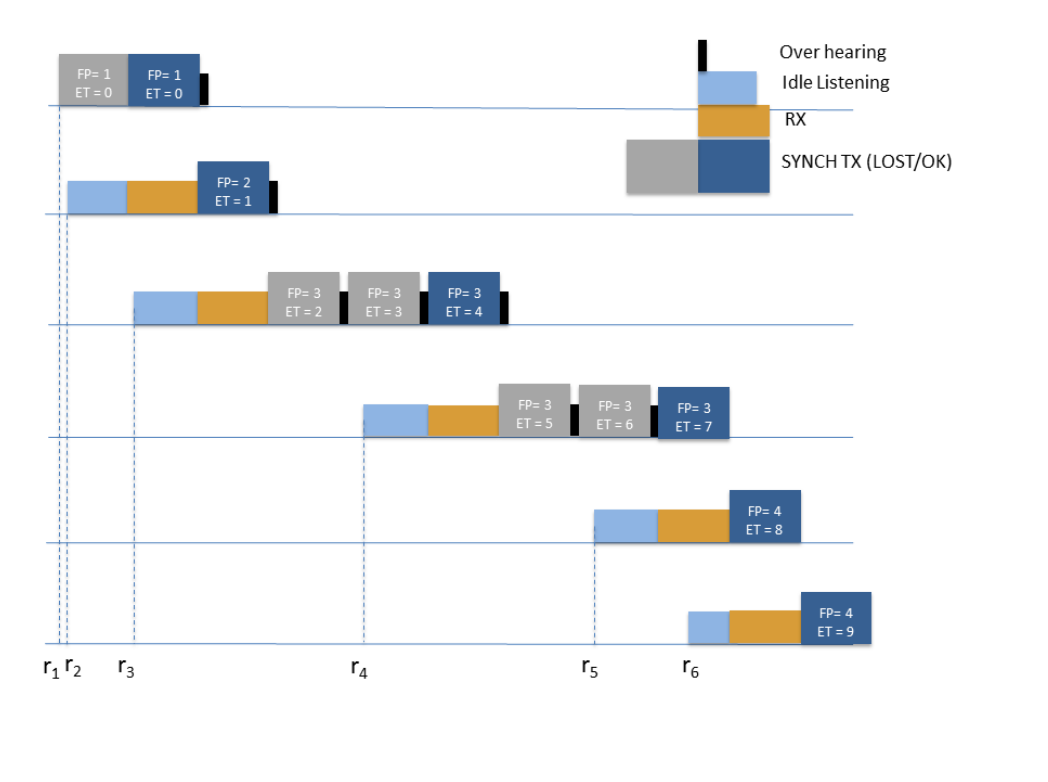
Figure 6. Illustrative example: synchronization protocol with the FP and ET values for the first 6